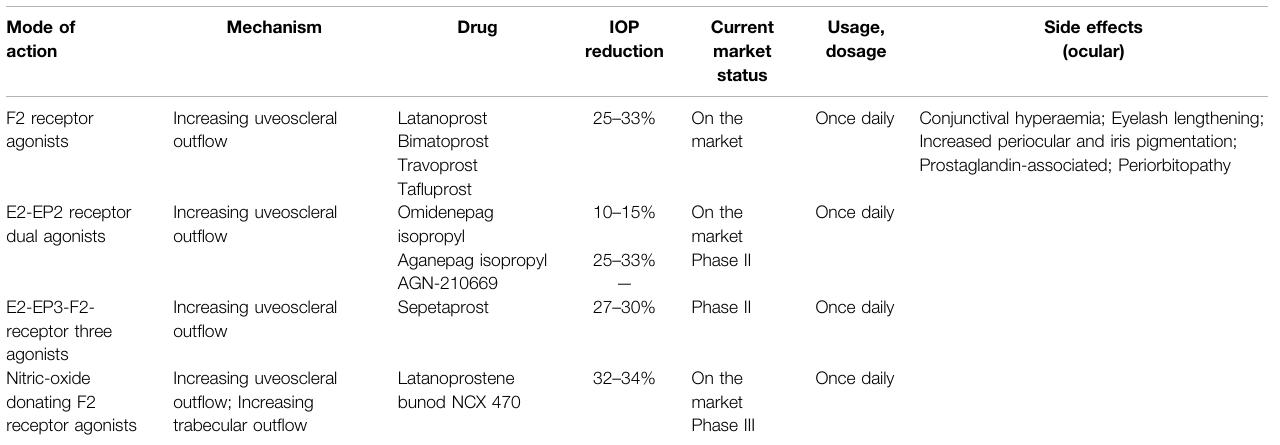
TABLE 1 | The class and list of Prostaglandin